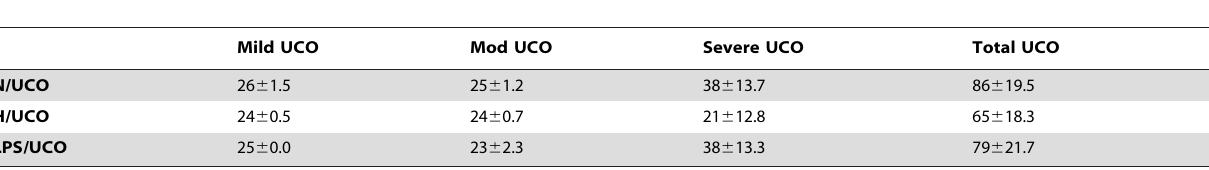
Table 1. Number of umbilical cord occlusions (UCOs) in each and all experimental stages.